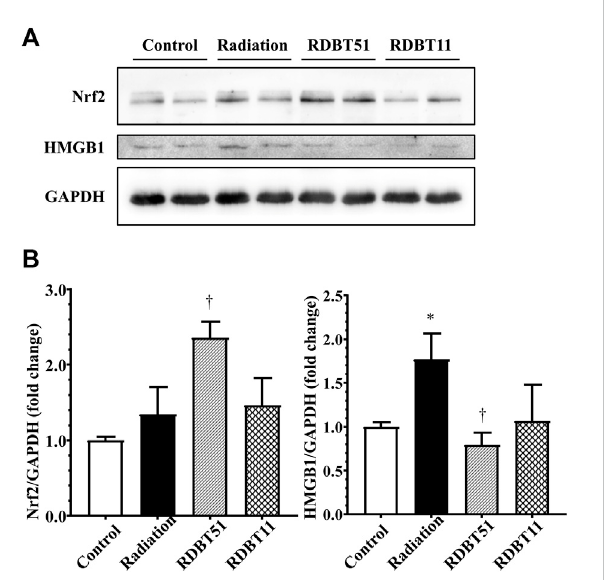
FIGURE 7 The regulatory effect of radiation and DBT on mouse myocardial Nrf2 and HMGB1 protein levels. (A) Representative western blot bands; (B) Quantitative results of Western blot. * p < 0.05 versus Control; † p < 0.05 versus Radiation. DBT, Dang Gui Bu Xue Tang; HMGB1, high mobility group box 1; RAM, Radix Astragali membranaceus ; RAS, Radix Angelicae sinensis ; RDBT51, Radiation with DBT (RAM: RAS = 5:1); RDBT11, Radiation with DBT (RAM: RAS =